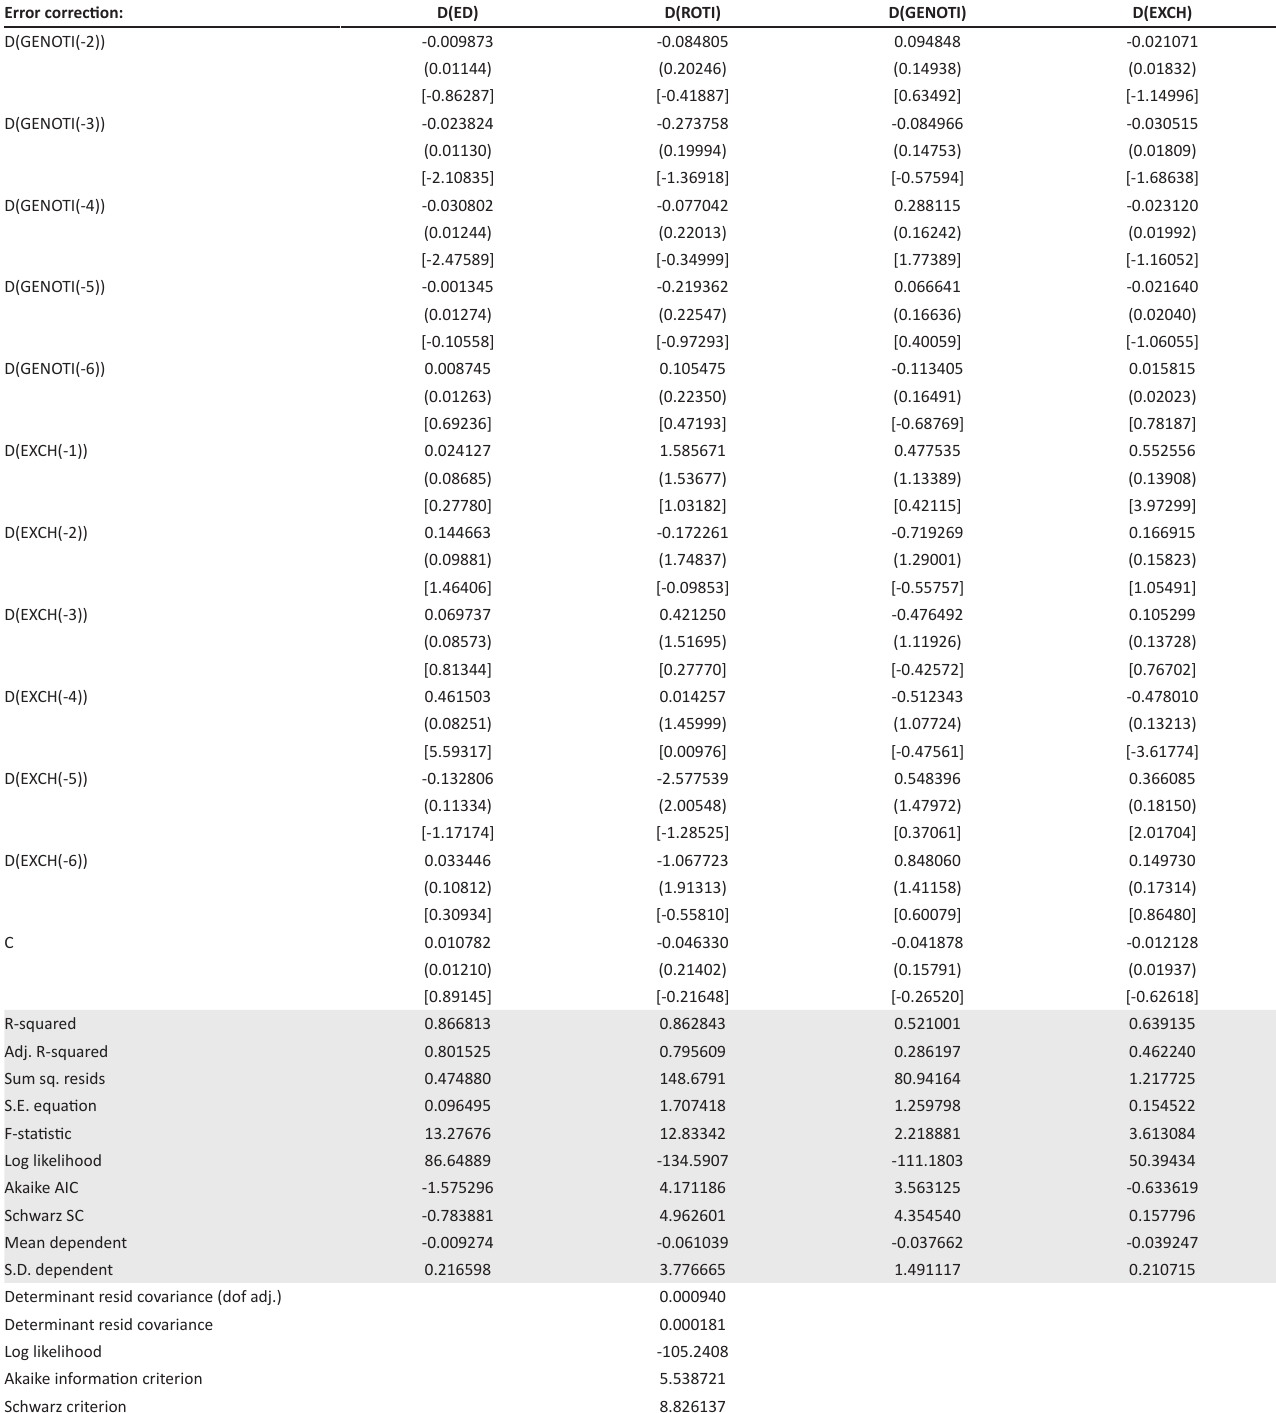
TABLE 1-A1 (Continues...): Vector error correction